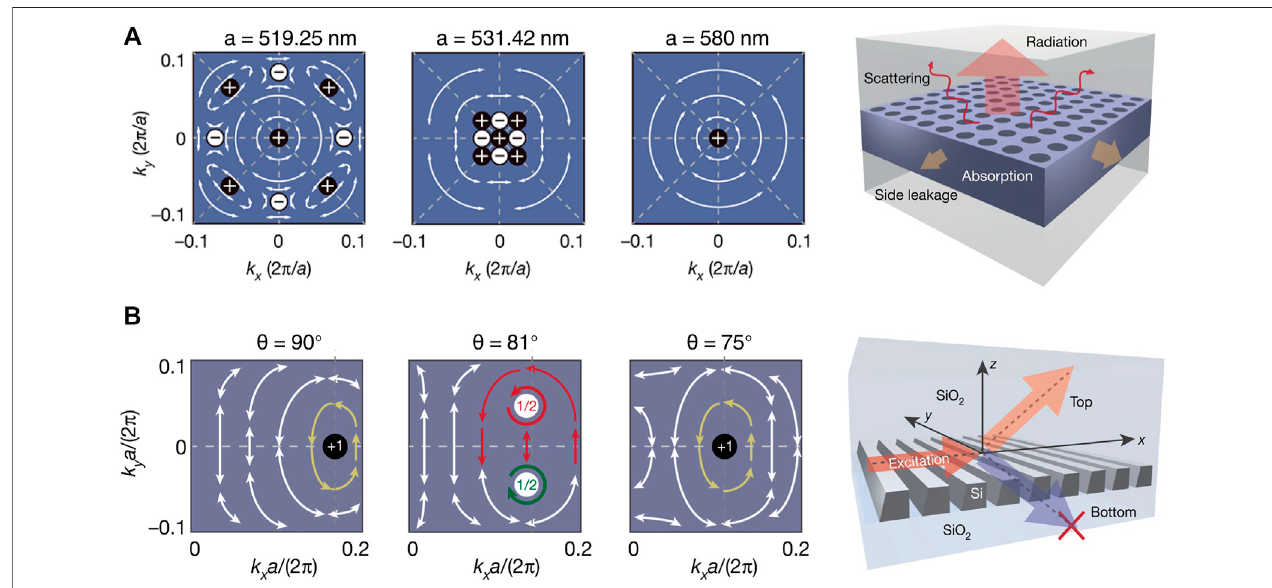
FIGURE 2 | Consequences of topological charge evolution. (A) A high- Q cavity robust of out-of-plane scatterings constructed by the merging of multiple integer charges [104]. (B) The merged half-charges in downward radiation leading to a unidirectional radiation [43]. Copyright Springer Nature Ltd.